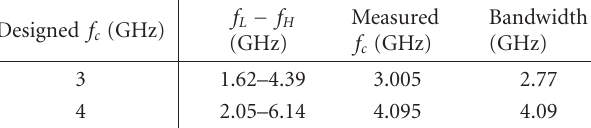
Table 2: Experimental results of the proposed antenna for di ff erent center frequencies. Design values for 3 GHz [ L = 73 . 5, W G = 73 . 5, L . 4, W W . 2, L . 8, R L G = 32, M = 16 M = 3, R = 8 R = 20 R = 12, . 3, S . 1, S . 3, S . 7, h = 1 . 6 (units in mm), S H 1 = 0 L 1 = 7 H 2 = 3 L 2 = 5 . 4]. Design values for 4 GHz [ L = 55, W L ε r = 4 G = 55, G = 24, . 3, W W . 2, L . 6, R S . 23, L M = 12 M = 3, R = 6 R = 15 R = 9, H 1 = 0